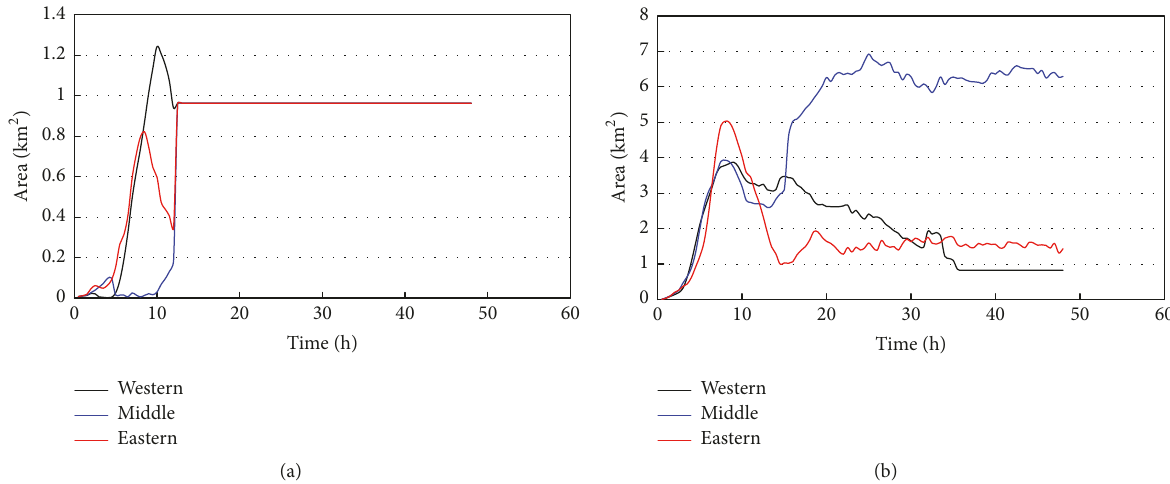
Figure 23: Area of instantaneous (a) and continuous (b) oil spills versus time in different spill locations (black line for the western spill location, blue line for the middle spill location, and red line for the eastern spill location) under the influence of northwest winds.